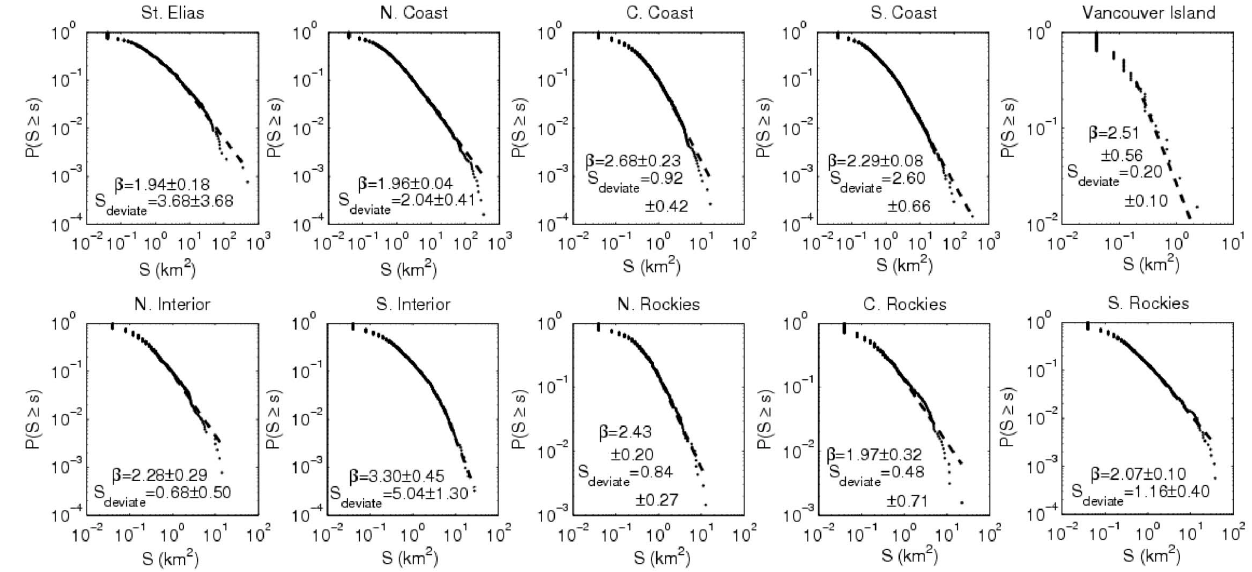
Fig. 3. The cumulative number–size distribution derived from a numerical flowshed algorithm for 10 different subregions of British Columbia. The location of each subregion is identified in Fig. 4. The dashed line shows the power-law fit. The power-law scaling exponent β is shown for each subregion, as is the lower bound S deviate below which a power-law is not guaranteed by the numerical data. Both β and S deviate are calculated using the statistical techniques outlined in Clauset et al. (2009). A weighted average of the regions gives β = 2 . 18 ± 0 . 11 and S deviate = 0 . 97 ± 1 . 29. Weights are the inverse of the error for each value of β and S deviate .